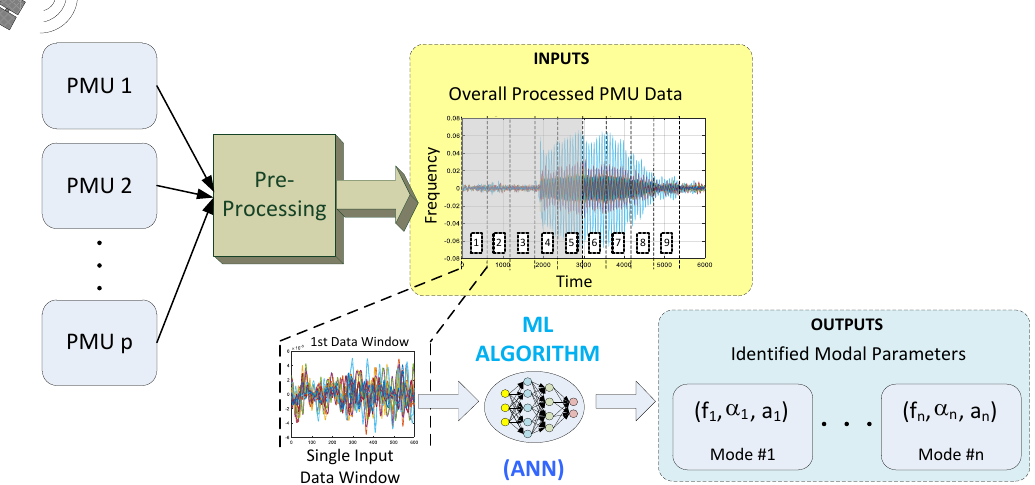
Figure 1. High-level schematization of the proposed low-frequency oscillations (LFO) modal parameters estimation technique.